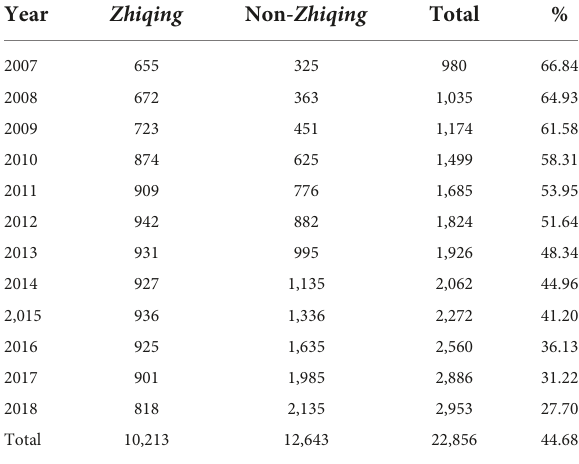
TABLE 2 Sample distribution